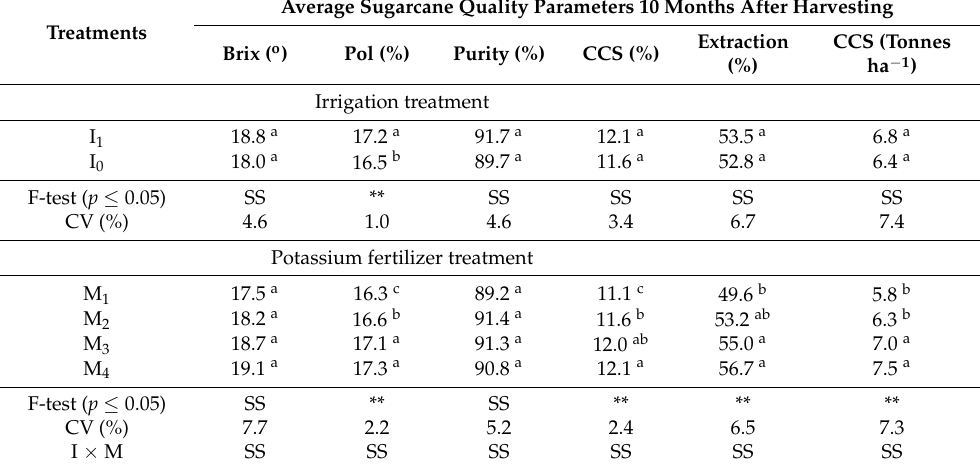
Table 6. Average sugarcane quality parameters 10 months after harvesting the seed crop under irrigation and potassium treatments.